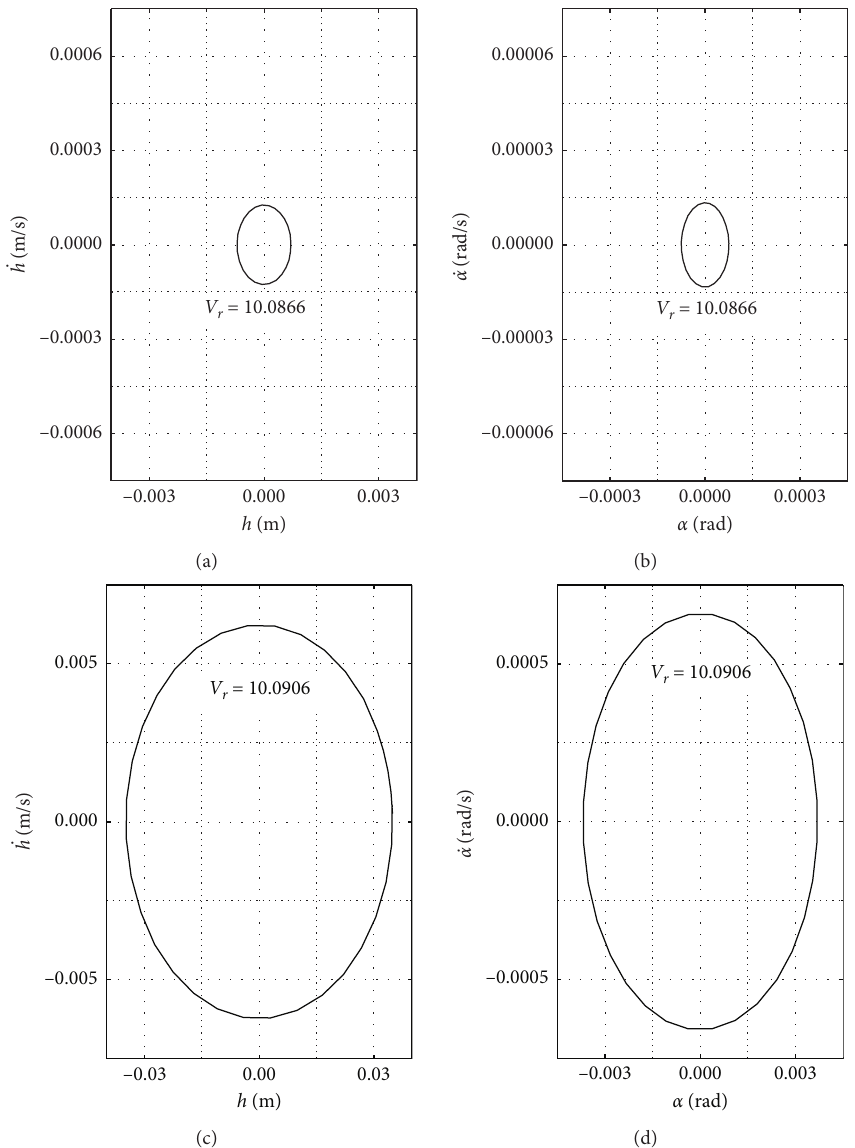
Figure 10: LCOs of two different reduced wind speed values. (a) LCO when V V � 10 . 0906. (d) LCO when V r